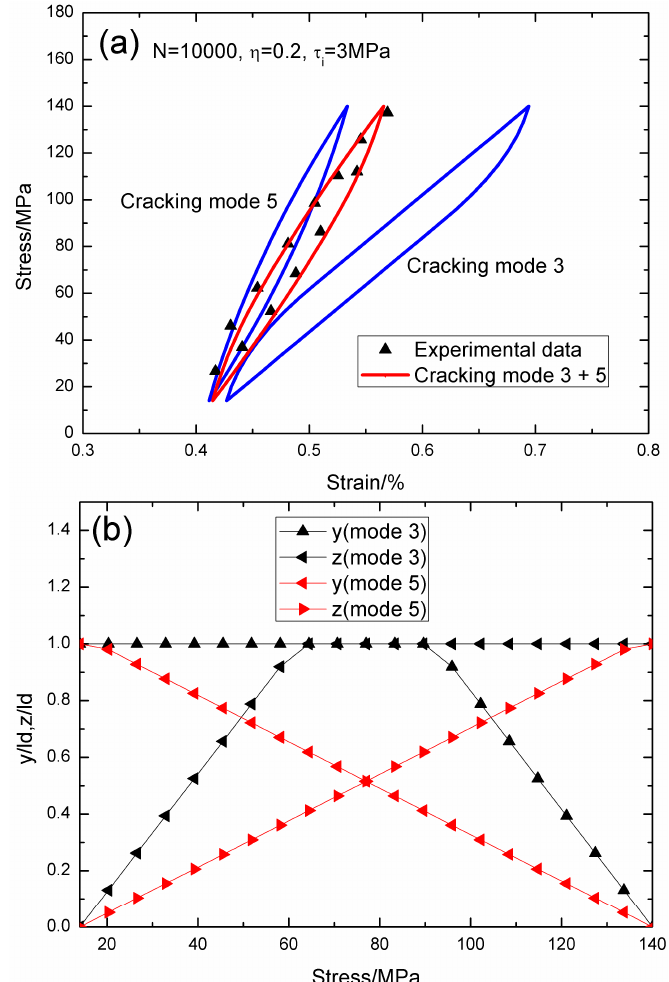
Figure 13. ( a ) The theoretical and experimental hysteresis loops; and ( b ) the interface slip lengths, i.e.